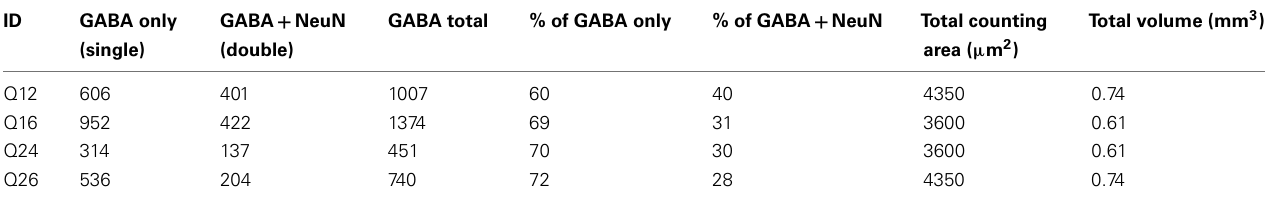
dotted lines represent the spinal gray matter, and white boxes represent the ROI in panels (B,F,J,N) . Majority of GABA-IR NPCs double labeled with NeuN-IR (B–D) . However, the GABA-IR NPCs did not colocalize with nestin (F–H) , GFAP (J–L) , or with β -III-tubulin (N–P)